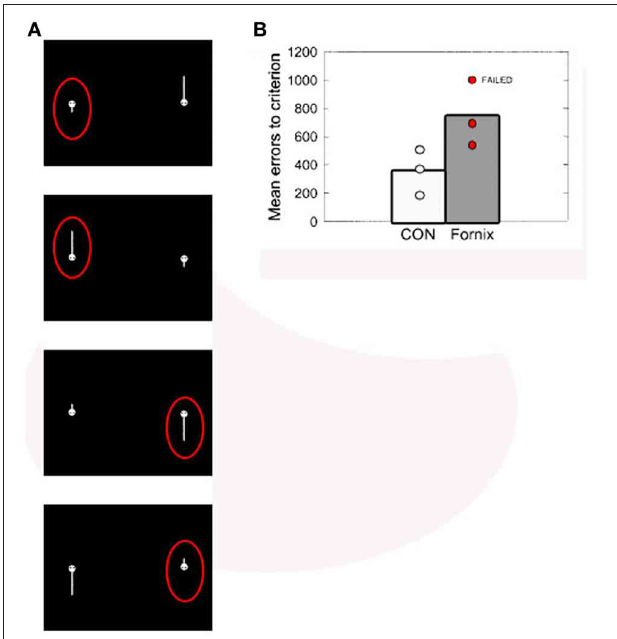
FIGURE 5 | (A) “Tadpole” stimuli used in Buckley et al. (2004). Each panel represents one of the four problems in the spatial configural task, with the correct choice for each pair circled in red. Because the three features (screen position, tail angle, and tail length) were maximally overlapping, solving the task required learning conjunctions of spatial features (e.g., for the top problem: short tail, angled down, on the left). (B) Individual and group mean errors to criterion for the control and fornix-transected monkeys in learning the spatial configural learning task. Figure adapted from Buckley et al.